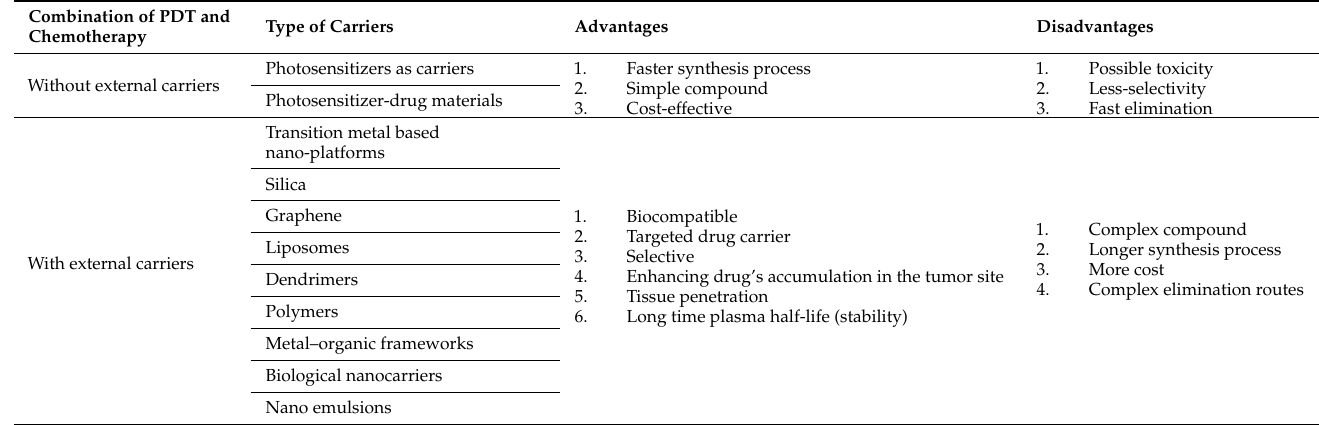
Table 1. Advantages and disadvantages of various nano-particles for cancer treatment.